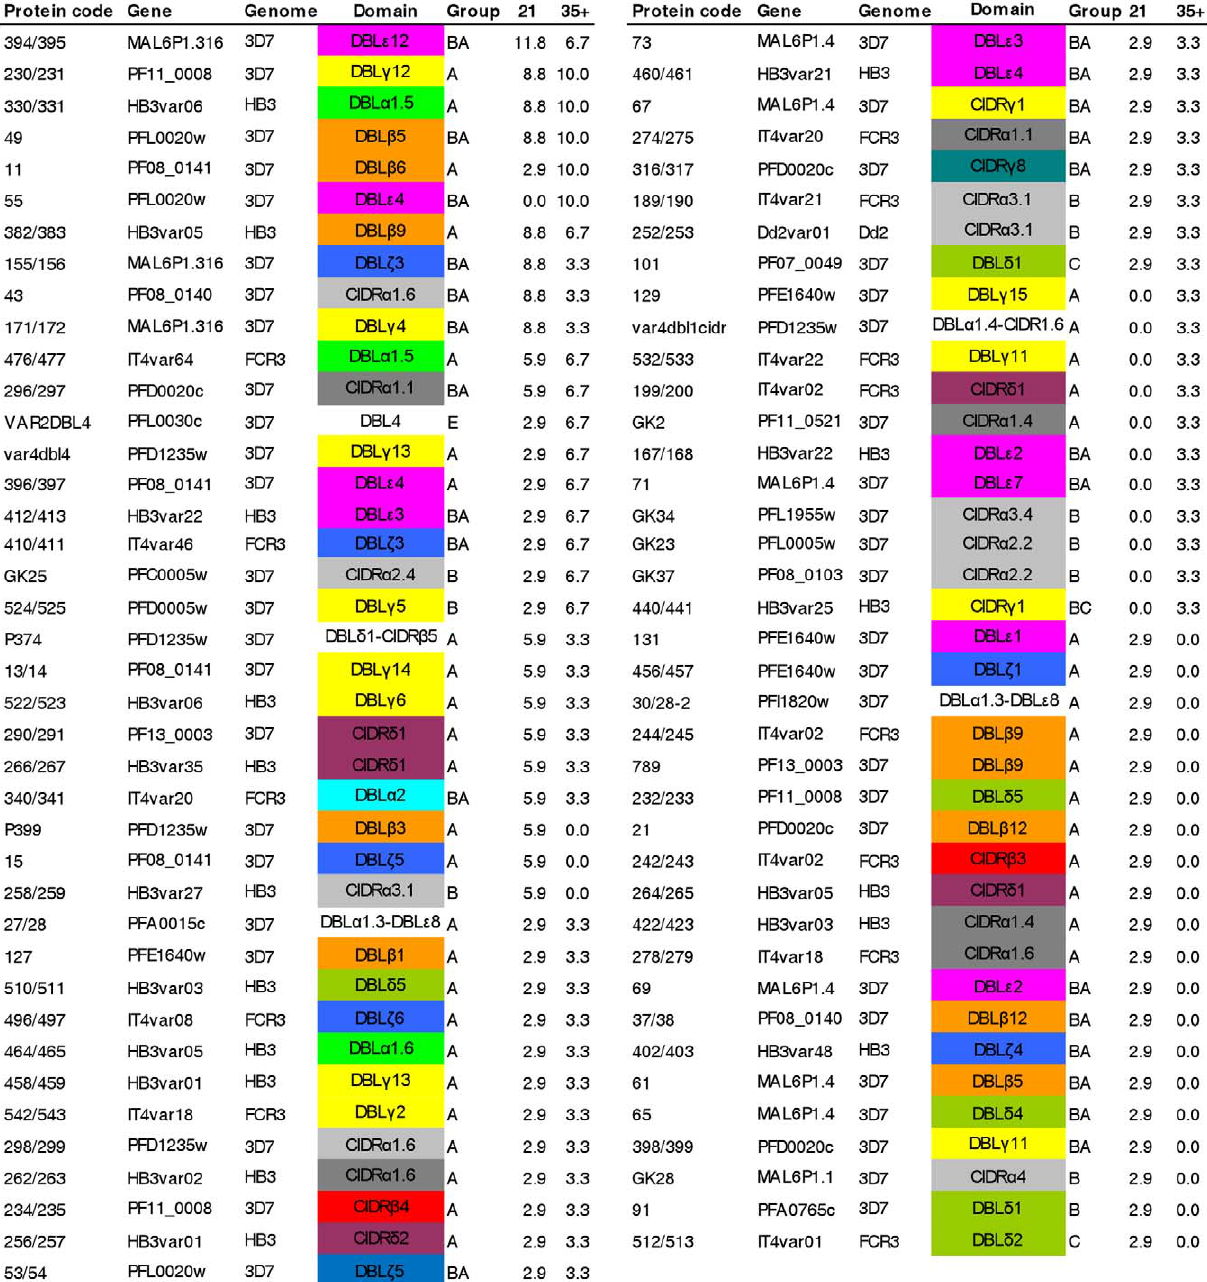
Figure 2. Proportion of malaria naı¨ve volunteers acquiring IgG against PfEMP1 antigens after controlled experimental P.falciparum infections. The percentage of malaria infected volunteers with a measurable IgG response against 79 PfEMP1 malaria antigens on day 21 (N=34) and/or day 35, 42 or 90 (N=30) post infection in descending order. The PfEMP1 domain classification was according to Rask et al [19]. 25 DBL and CIDR domains were omitted from the figure as there was no IgG recognition of these domains (see Table S2). In total 44 volunteers were included (Table S1) and the IgG response was measured by bead-based Luminex technology.